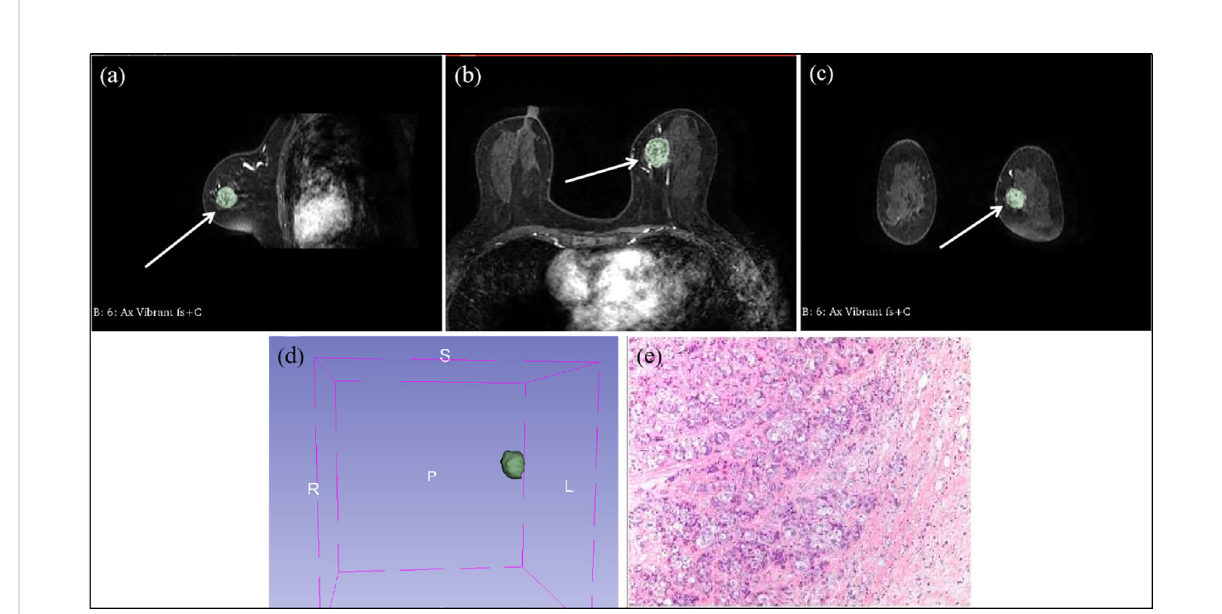
FIGURE 2 Multi-level step-by-step sketching of tumor lesions at contrast-enhanced T1-weighted MRI in a 49 year-old woman with invasive ductal cancer of the left breast. (A) sagittal position image shows an irregular shaped, irregular margined, heterogeneous enhancing mass (arrow). (B) transverse position image shows an irregular shaped, irregular margined, heterogeneous enhancing mass (arrow). (C) coronal position image shows an irregular shaped, irregular margined, heterogeneous enhancing mass (arrow). (D) the VOI fused into the outlined images step-by-step. (E) the pathological microscopic picture of invasive ductal cancer of the left